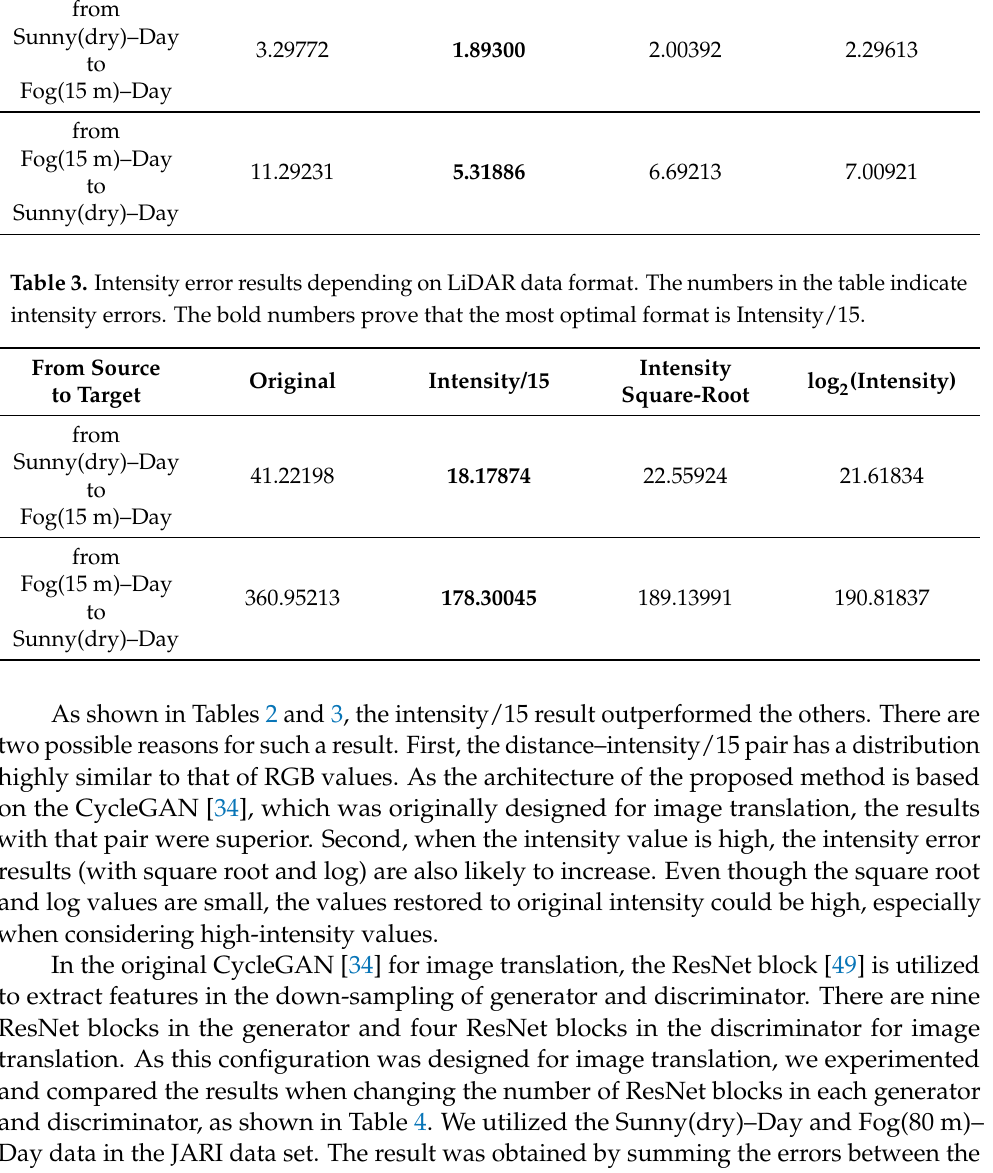
Table 2. Distance error results depending on LiDAR data format. The numbers in the table indicate distance errors (in m). The bold numbers show that the most optimal format is Intensity/15. From Source Original Intensity/15 to Target